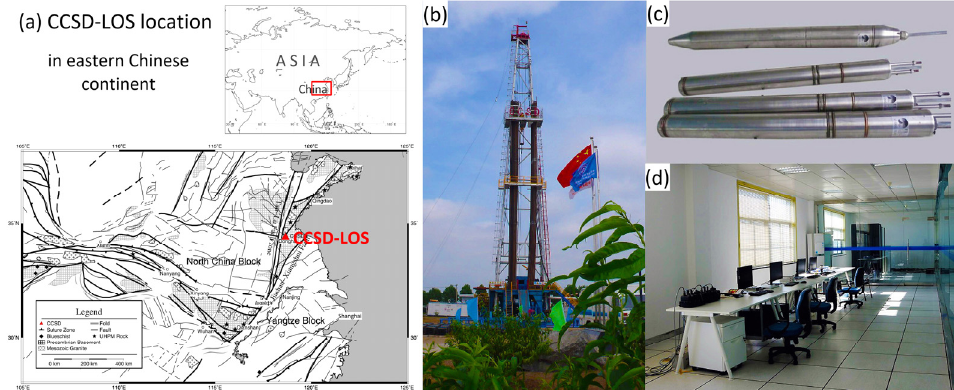
Figure 1. The CCSD long-term crustal movement observation station (CCSD-LOS). ( a ) The location of the station in China; ( b ) the observation borehole of the CCSD-LOS. The picture shows the derrick and drill pipes for the installation of instruments, with a 5158 m-deep hole below; ( c ) some underground probes installed in the boreholes. They have now been installed in 4 layers underground; and ( d ) the supervisory control room.